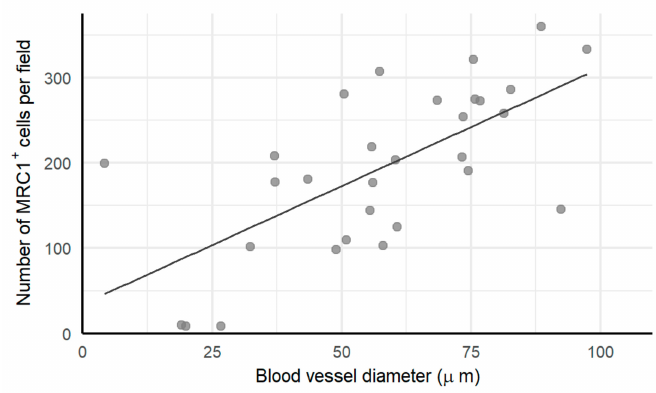
Figure 6. Correlation between blood vessel width and M2 macrophages. A larger blood vessel denotes more M2 macrophages infiltrating the tumor (Spearman correlation coe ffi cient of